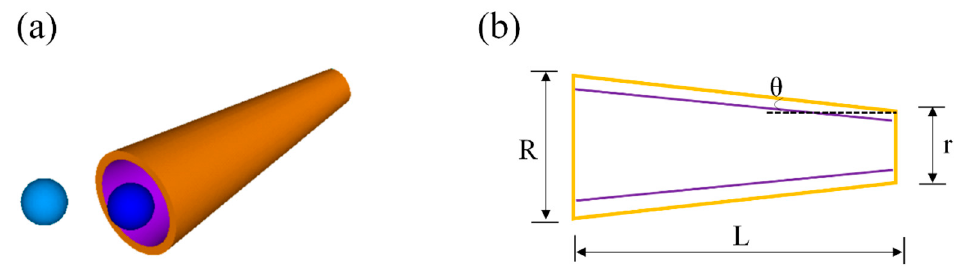
Figure 2. Promoting motion performance of a cone-shaped tubular micromotor by optimizing the geometry. ( a ) General schematic of a cone-shaped tubular micromotor. ( b ) A description of dimension label of conical micromotors. The motion performance of the motor could be promoted by optimizing the geometry, including reducing the ratio of length to radius or enlarging the semi-cone angle.